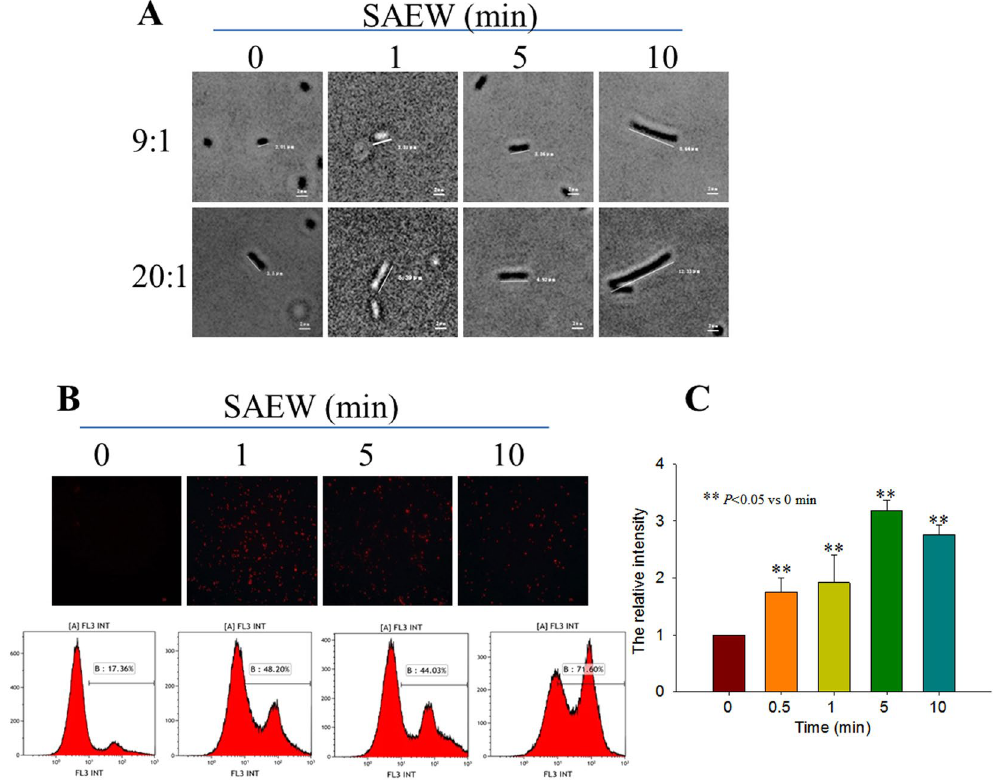
Figure 4. SAEW induced E. coli morphology and permeability changes. ( A ) The representative cell morphology data were observed under a microscope. (B) The representative cell permeability data were observed under a fluorescence microscope and by flow cytometry. (C) The statistical data of the relative PI fluorescence intensity were measured by flow cytometry (n = 4, ** P < 0.01 vs 0